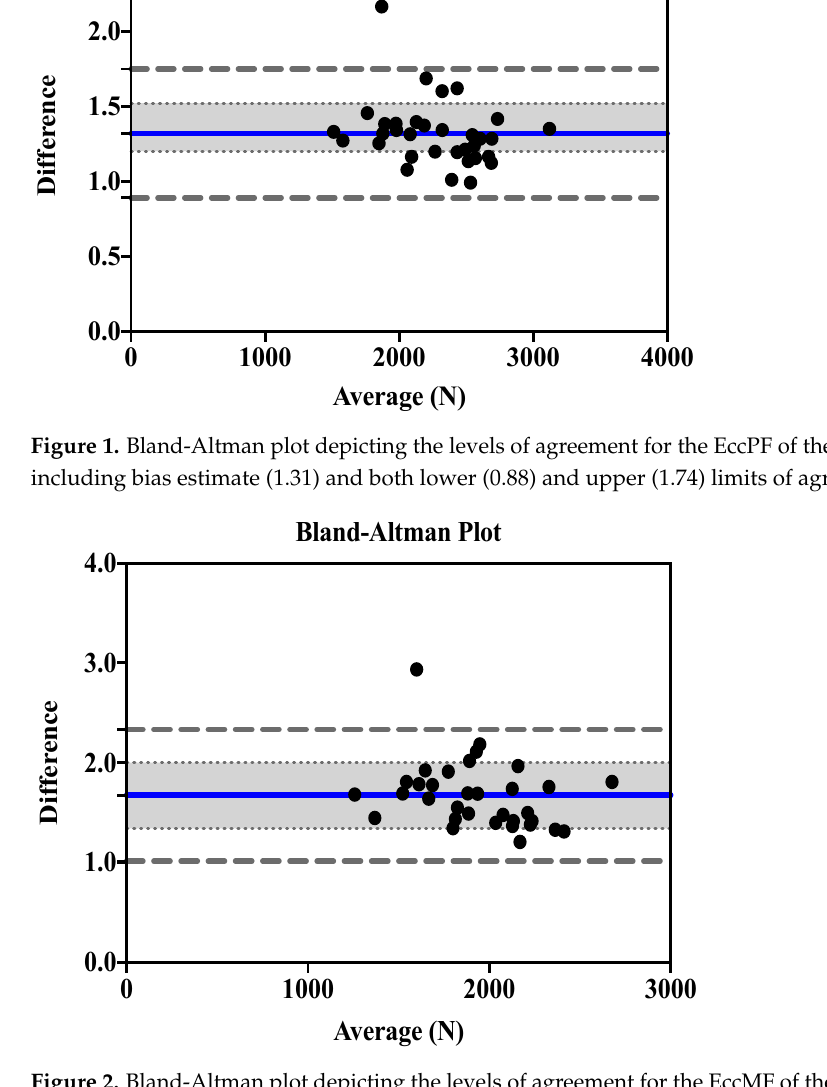
Figure 2. Bland-Altman plot depicting the levels of agreement for the EccMF of the 1RM-BS and CMJ, including bias estimate (1.67) and both lower (1.01) and upper (2.33) limits of agreement.